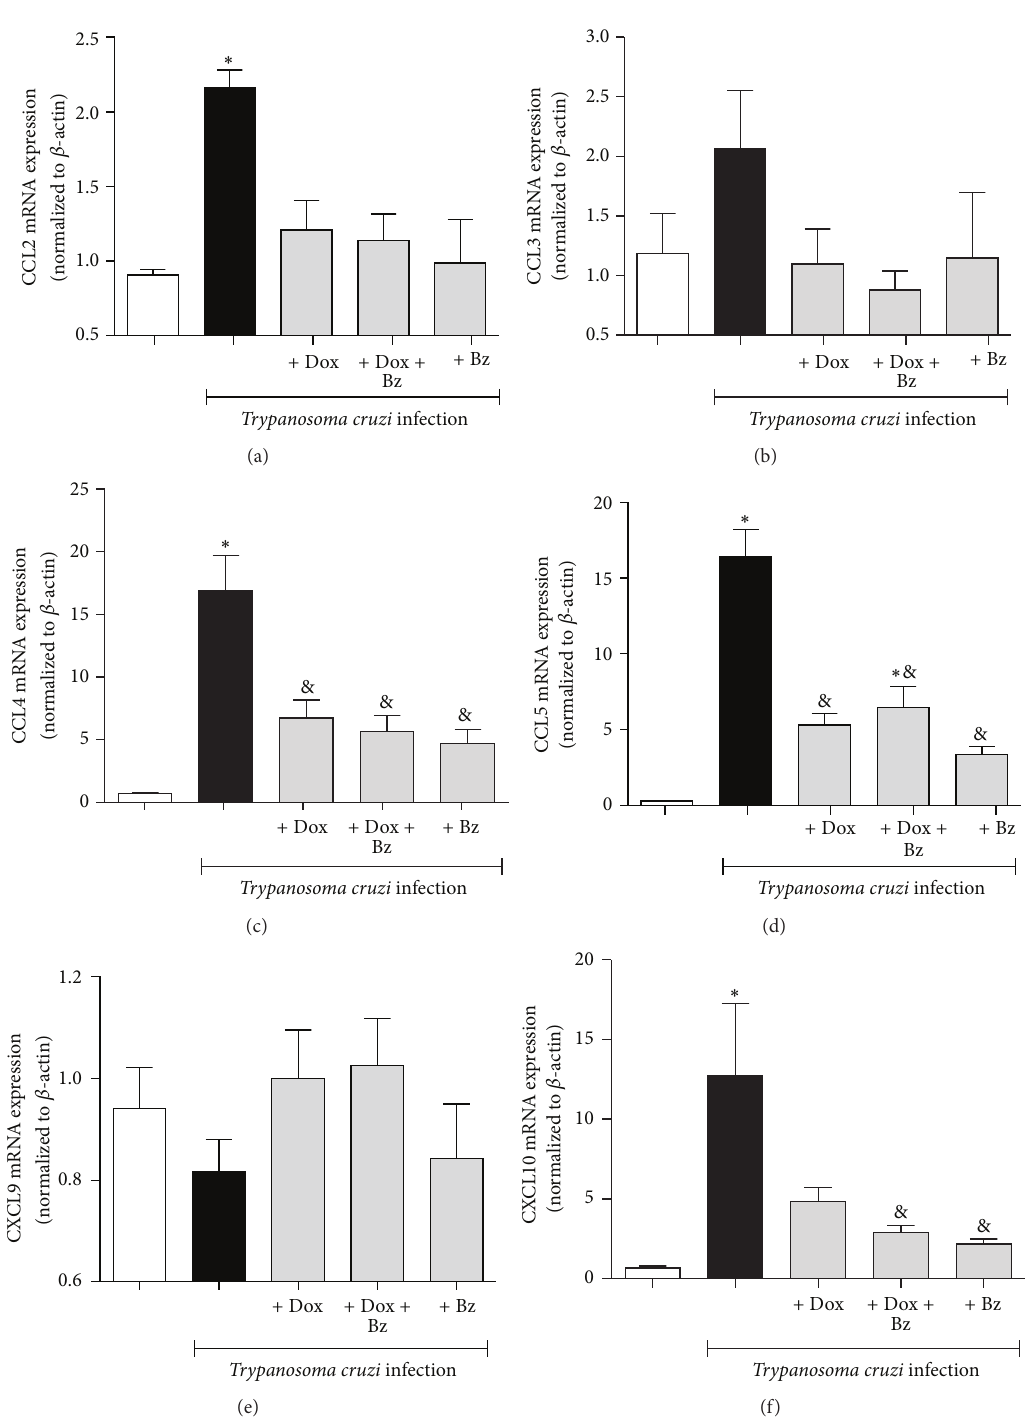
Figure 1: Expression of Th1-like chemokines in the cardiac tissue from dogs infected with Trypanosoma cruzi . Mongrel dogs were infected ( black bars ), or not ( white bars ), with Berenice-78 strain of T. cruzi and treated daily for 12 months with doxycycline (Dox), for 60 days with benznidazole (Bz), or in association with Dox + Bz ( grey bars ) and Th1-like chemokines CCL2, CCL3, CCL4, CCL5, CXCL9, and CXCL10 mRNA expression evaluated in left ventricle tissues from these animals. Data are representative of groups of 5 animals in which expression of chemokines was normalized to the constitutive beta-actin. ∗ 𝑝 < 0.05 in relation to the noninfected group; & 𝑝 < 0.05 in relation to the infected group without